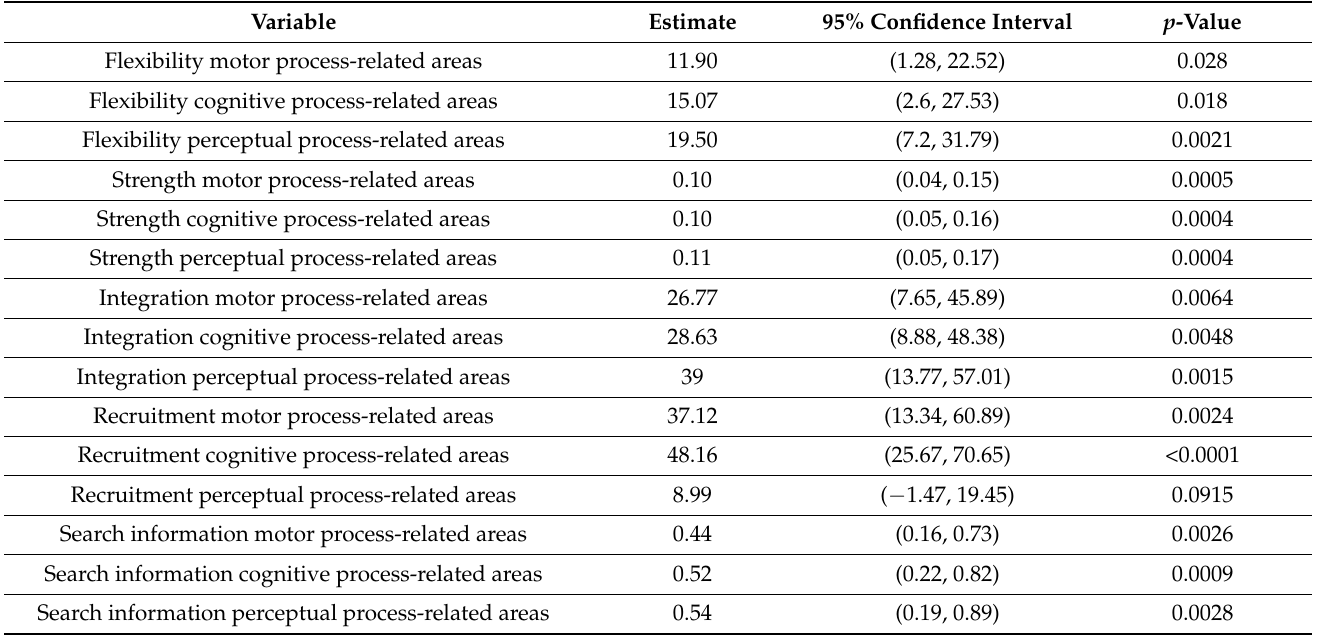
Table 2. Univariate analysis results representing the relationship between performance and EEG features. Variable Estimate 95% Confidence Interval p